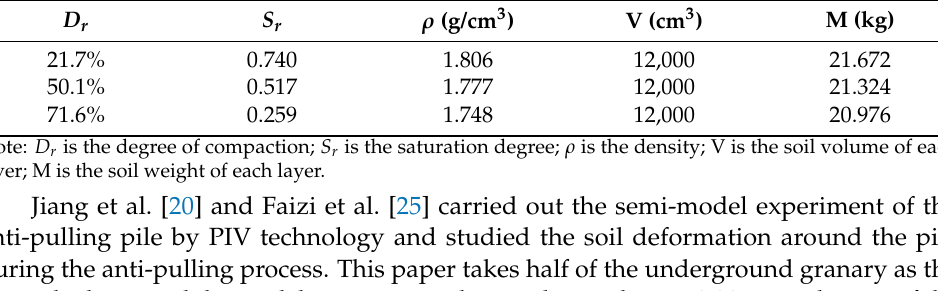
Table 2. The calculated results of the sand sample with different degree of